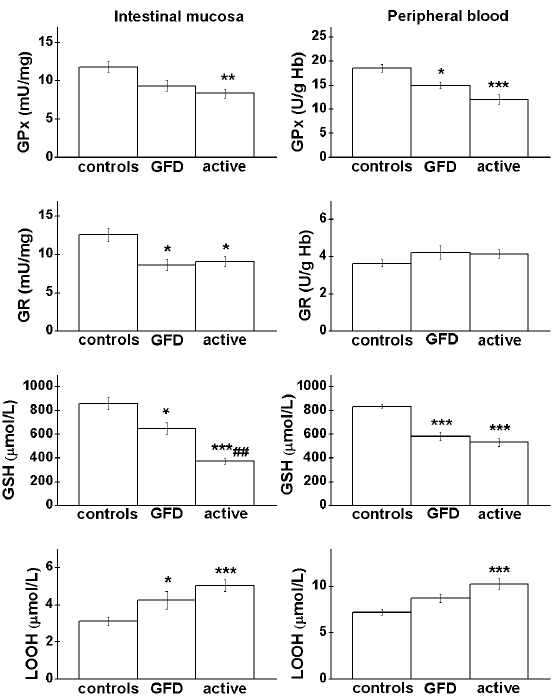
Figure 1. The activities of glutathione peroxidase (GPx) and glutathione reductase (GR) and the concentrations of glutathione (GSH) and lipid hydroperoxides (LOOH) in small intestinal mucosa and peripheral blood of control subjects, patients on gluten-free diet (GFD) and patients with the active form of the celiac disease. *** P < 0.001, ** P < 0.01, * P < 0.05 significantly different from control subjects. ## P < 0.01 significantly different from the GFD